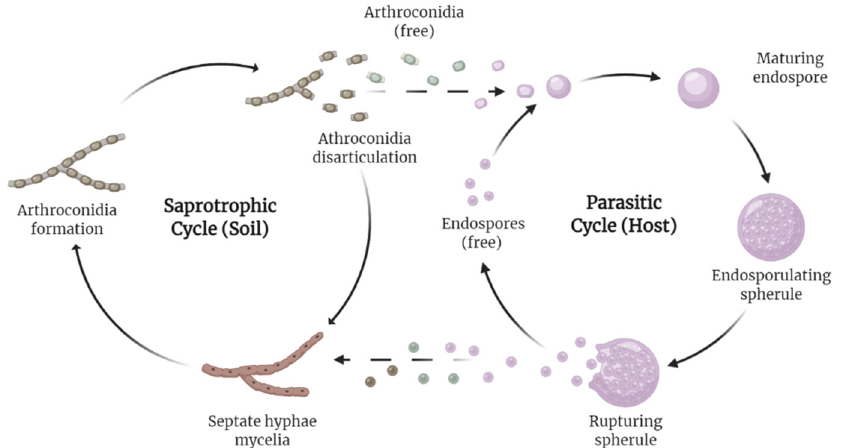
Figure 2. Life cycle of Coccidioides . The fungus possesses a dimorphic life cycle, living saprotrophically in soil and parasitically in its host at different intervals of the cycle. Recently, an alternative hypothesis formed, suggesting the species may be endozoan.